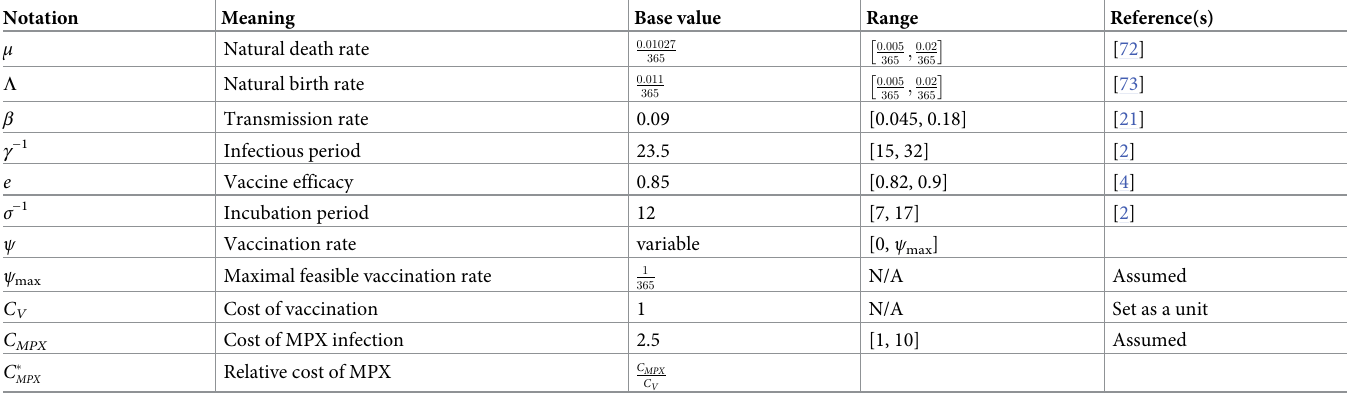
Table 1. Model parameters. Times are in days, rates are per capita per day (and Λ is individuals per day). Details on model calibration are shown in Section